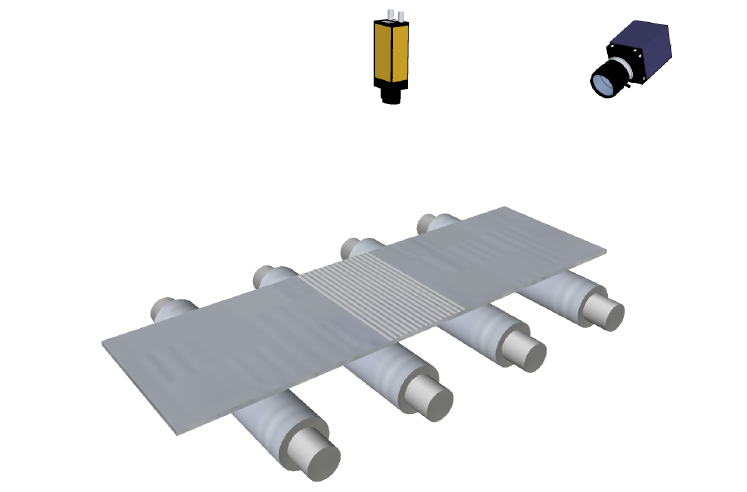
Figure 11. Flatness sensor based on fringe